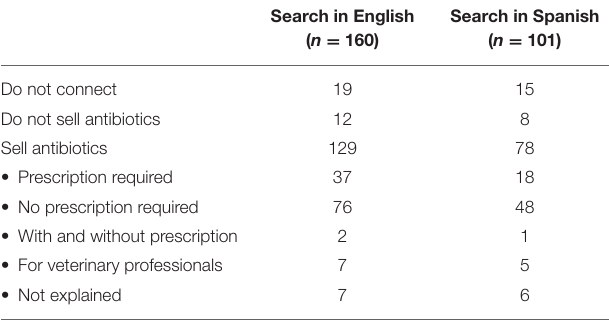
TABLE 4 | Characteristics of the web pages